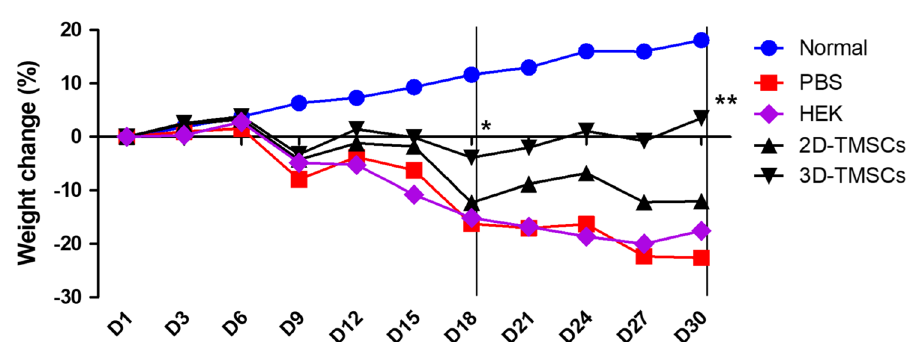
Figure 4. Weight recovery after treatment with 3D-cultured TMSCs. Body weight loss in the 3D-TMSC-treated group was significantly mitigated when compared with that in the DSS + PBS, the DSS + HEK and 2D-TMSC- treated groups. *On day 18, the body weight loss in the 3D-TMSC-treated group was lower than that in the DSS + PBS (P < 0.001), the DSS + HEK (P = 0.188), and 2D-TMSC-treated groups (P = 0.005). **On day 30, the body weight loss in the 3D-TMSC-treated group was significantly lower than that in the DSS + PBS (P = 0.001), the DSS + HEK (P = 0.027), and 2D-TMSC-treated groups (P = 0.005). 3D, three-dimensional; 2D, two- dimensional; TMSCs, tonsil-derived mesenchymal stem cells; DSS, dextran sulfate sodium; PBS, phosphate- buffered saline; HEK, human embryonic